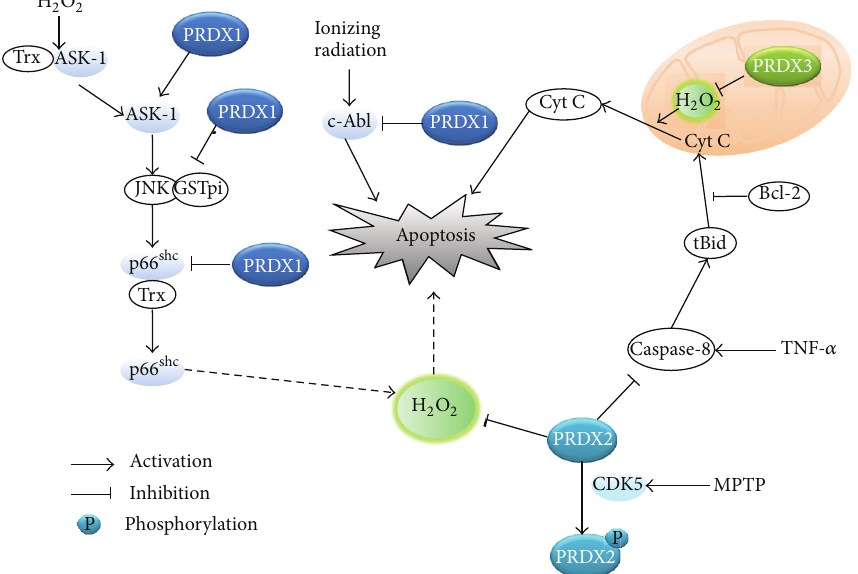
Figure 2: Role of typical 2-Cys Prxs in the apoptotic death pathways. The schematic drawing illustrates that each Prx interacts with proapoptotic molecules and regulates various apoptotic pathways. MPTP: